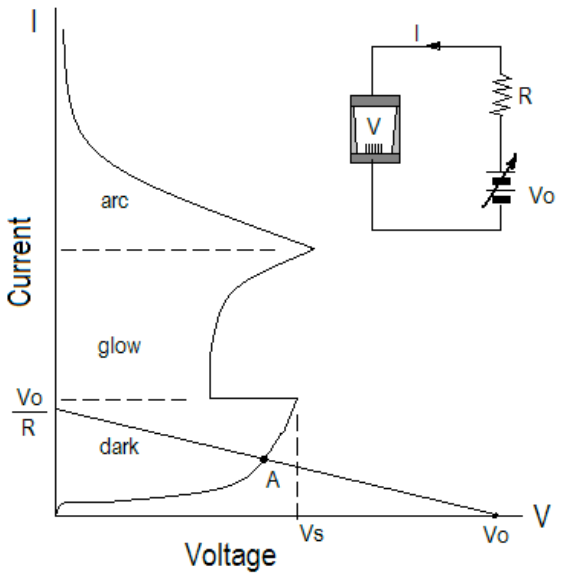
Figure 5. A typical discharge I-V curve in ideal